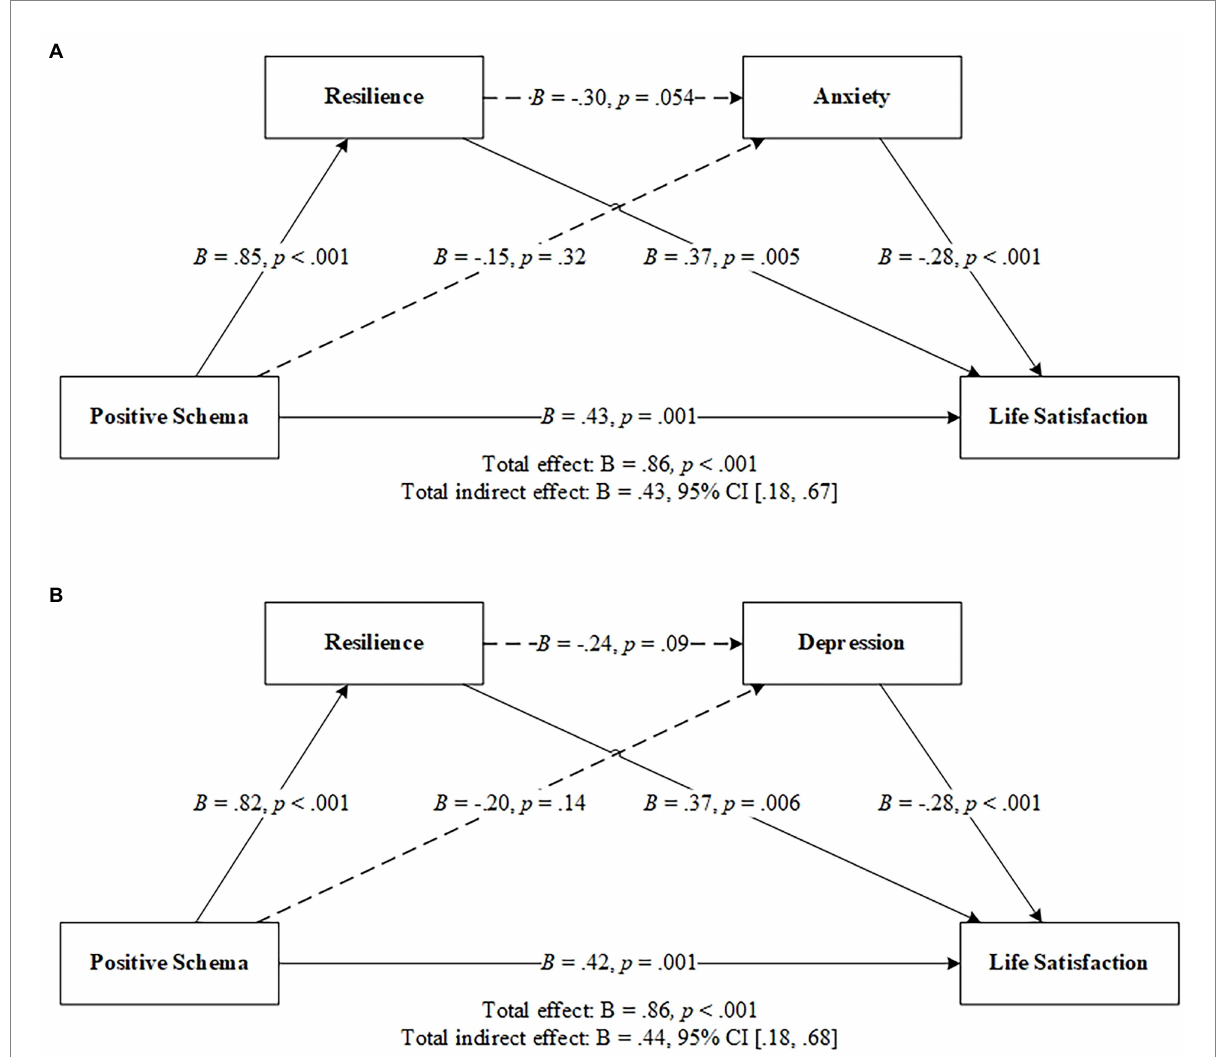
FIGURE 1 Resilience and anxiety (A) /depression (B) as serial mediators between positive schema and life satisfaction. N = 129. CI, confidence interval. Solid lines indicate significant paths, and dotted lines indicate nonsignificant paths. Results were based on 5,000 bootstrap samples.